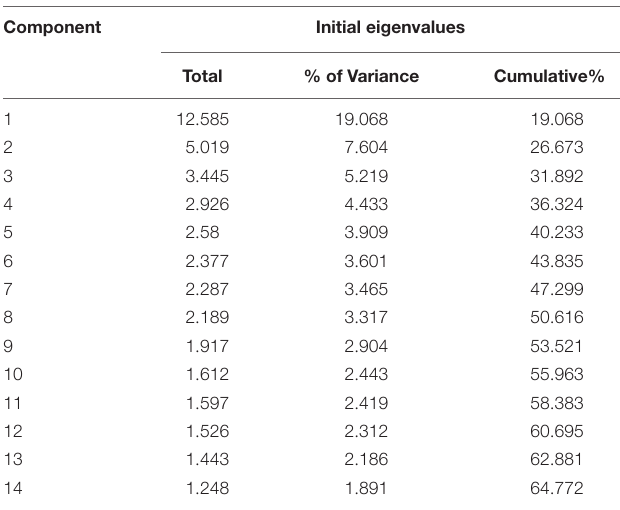
TABLE 1 | Common method biases test analysis.